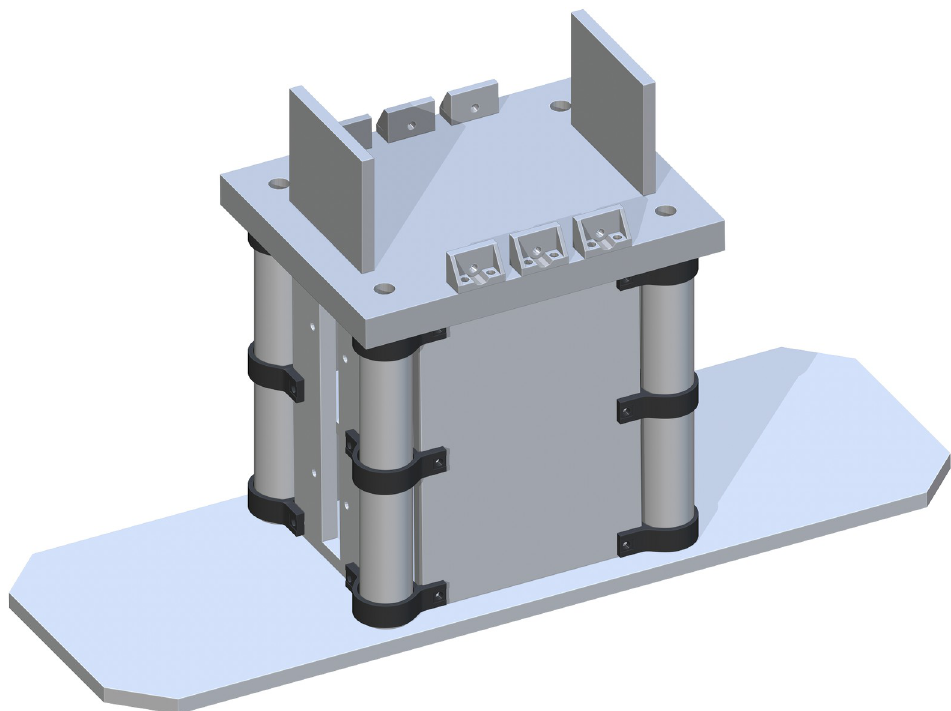
Fig 8. Finishing the addition of Lower_Arc_for_Table_Bracket’s.